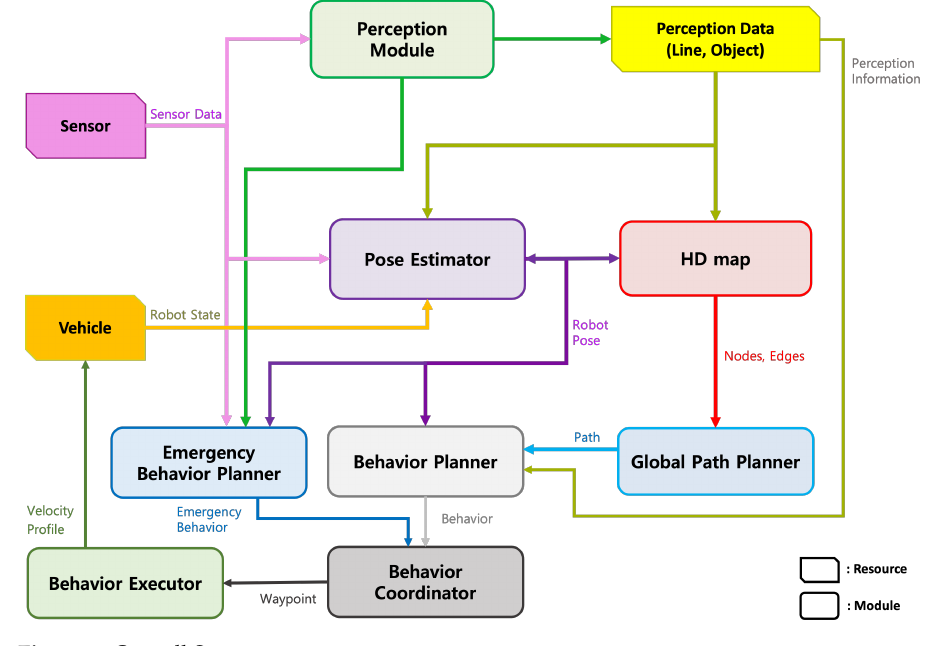
Figure 6. Overall System.